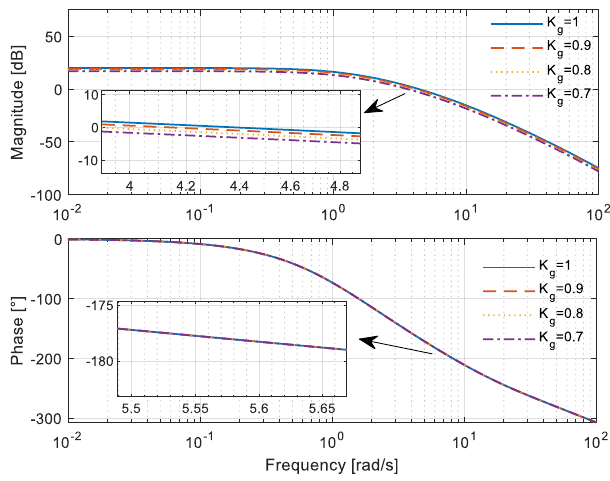
Figure 3. Bode diagrams of the open-loop system.